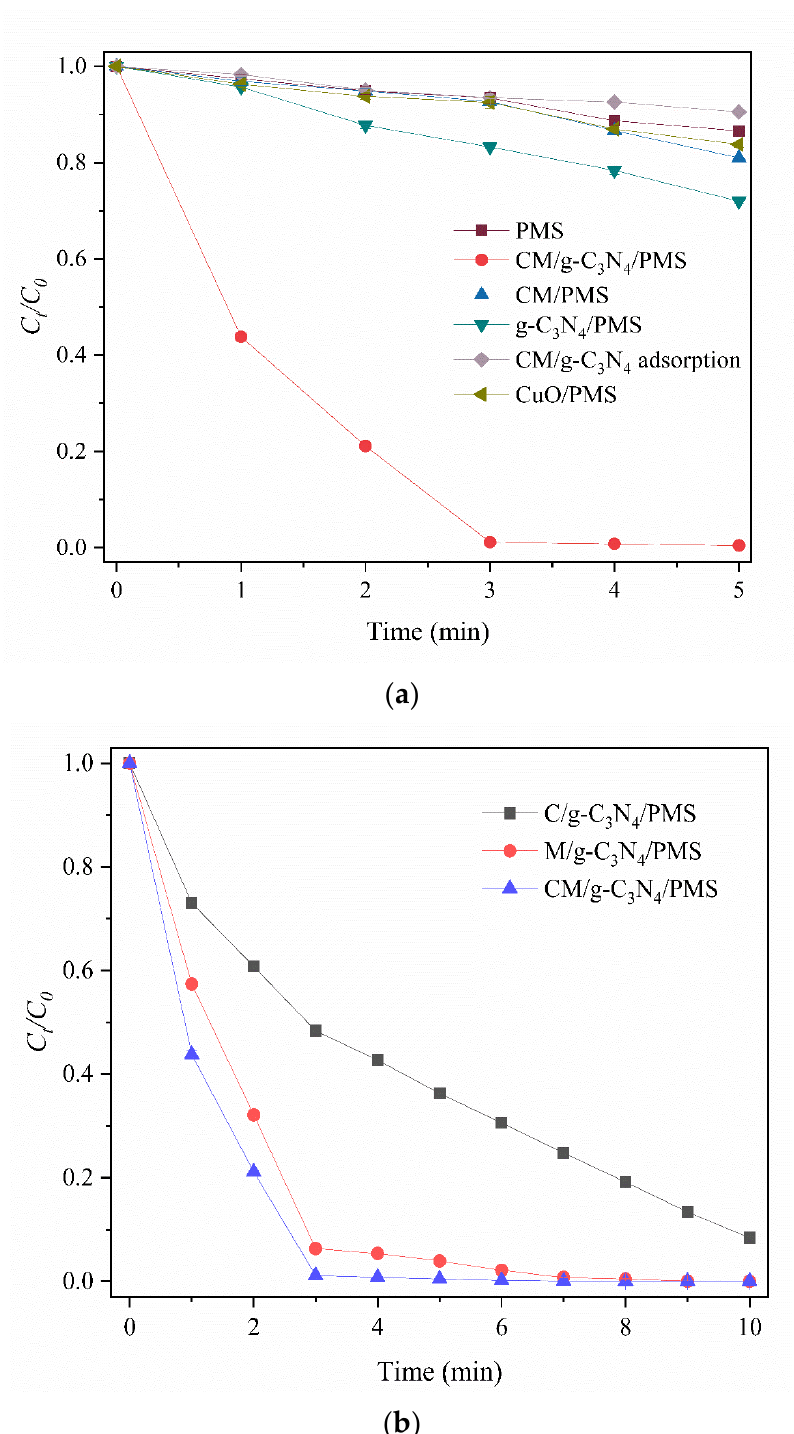
Figure 1. Degradation of RhB under different systems ( a , b ). Reaction conditions: [PMS] = 2.0 mM, [catalyst] = 0.50 g/L, [RhB] = 10.0 mg/L, 25 °C.